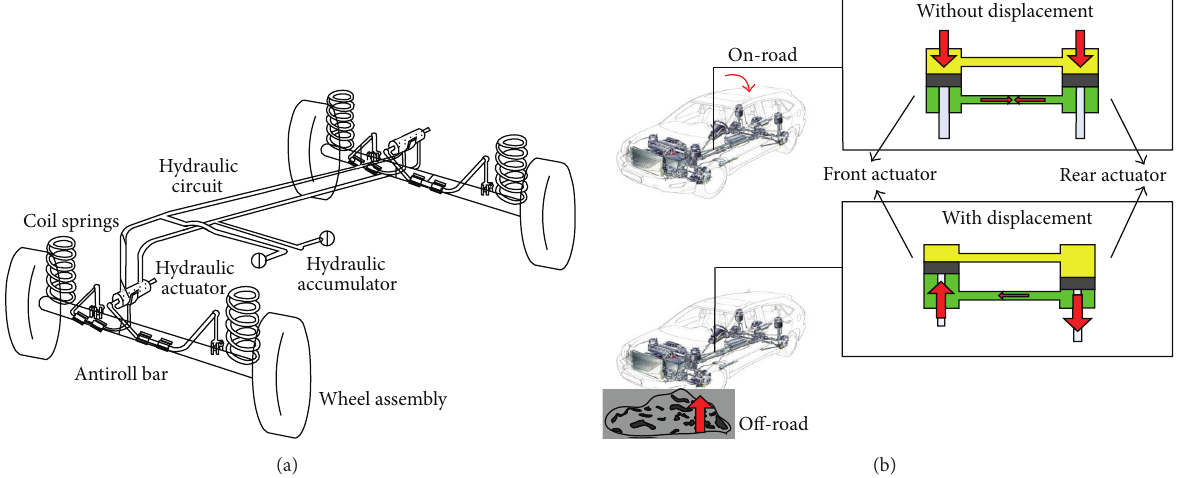
Figure 1: (a) A schematic layout of a two-axle vehicle with KDS system. (b) The working condition of a two-axle vehicle with KDS system.